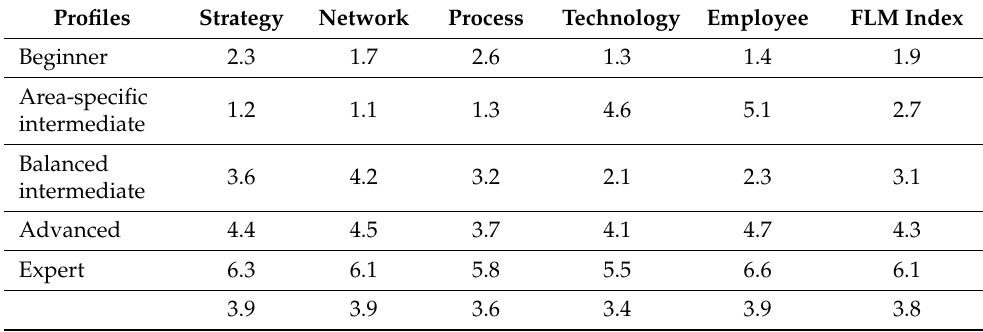
Table 3. Dimension specifications of the identified